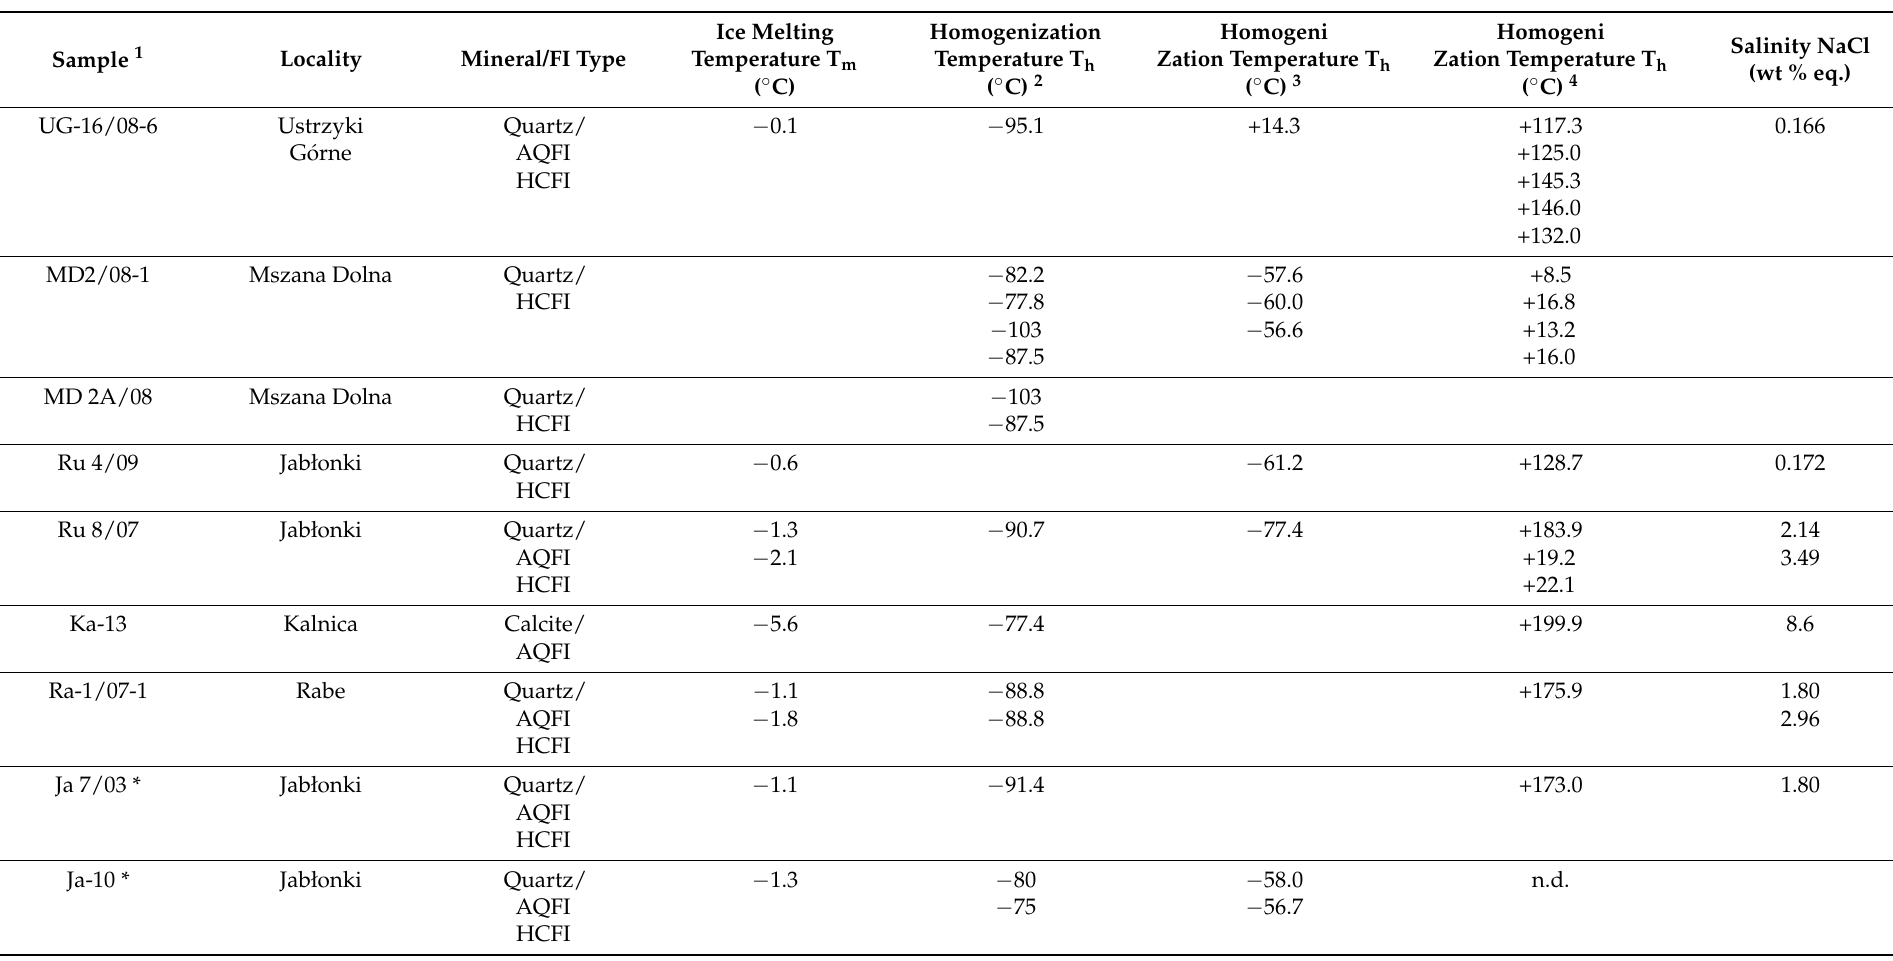
Table 2. Results of fluid inclusion studies in quartz from fissures in the MD and JRC